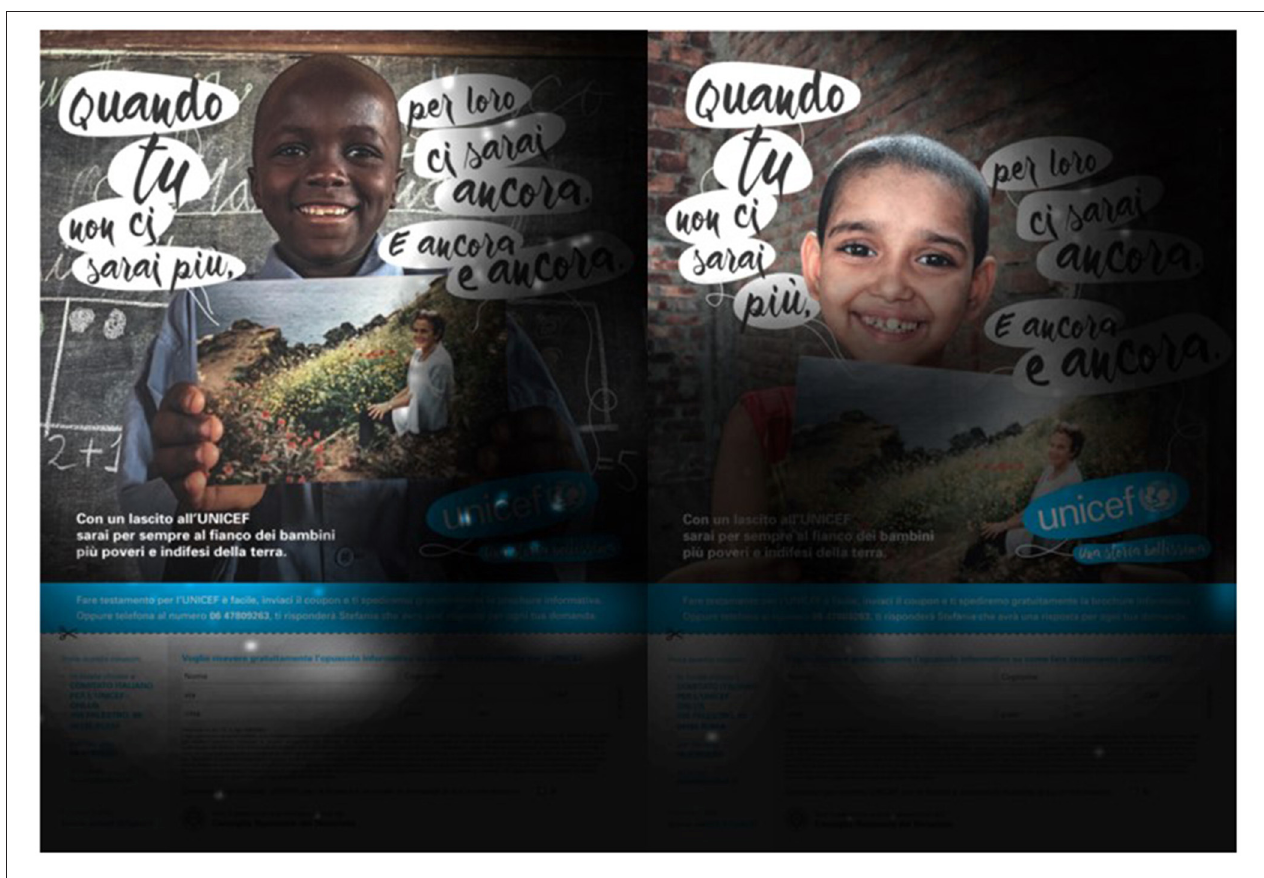
FIGURE 6 | Shadow map on Unicef flyers.